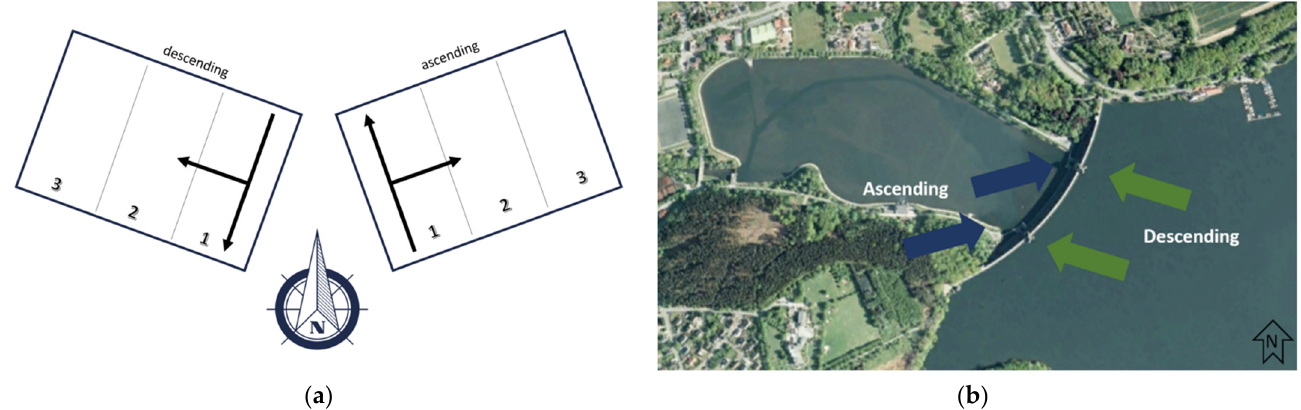
Figure 2. Study area of this investigation: ( a ) Descending and ascending flight directions of Sentinel- 1; ( b ) Photo of the Moehne Gravity Dam [31]. ( b ) Photo of the Moehne Gravity Dam